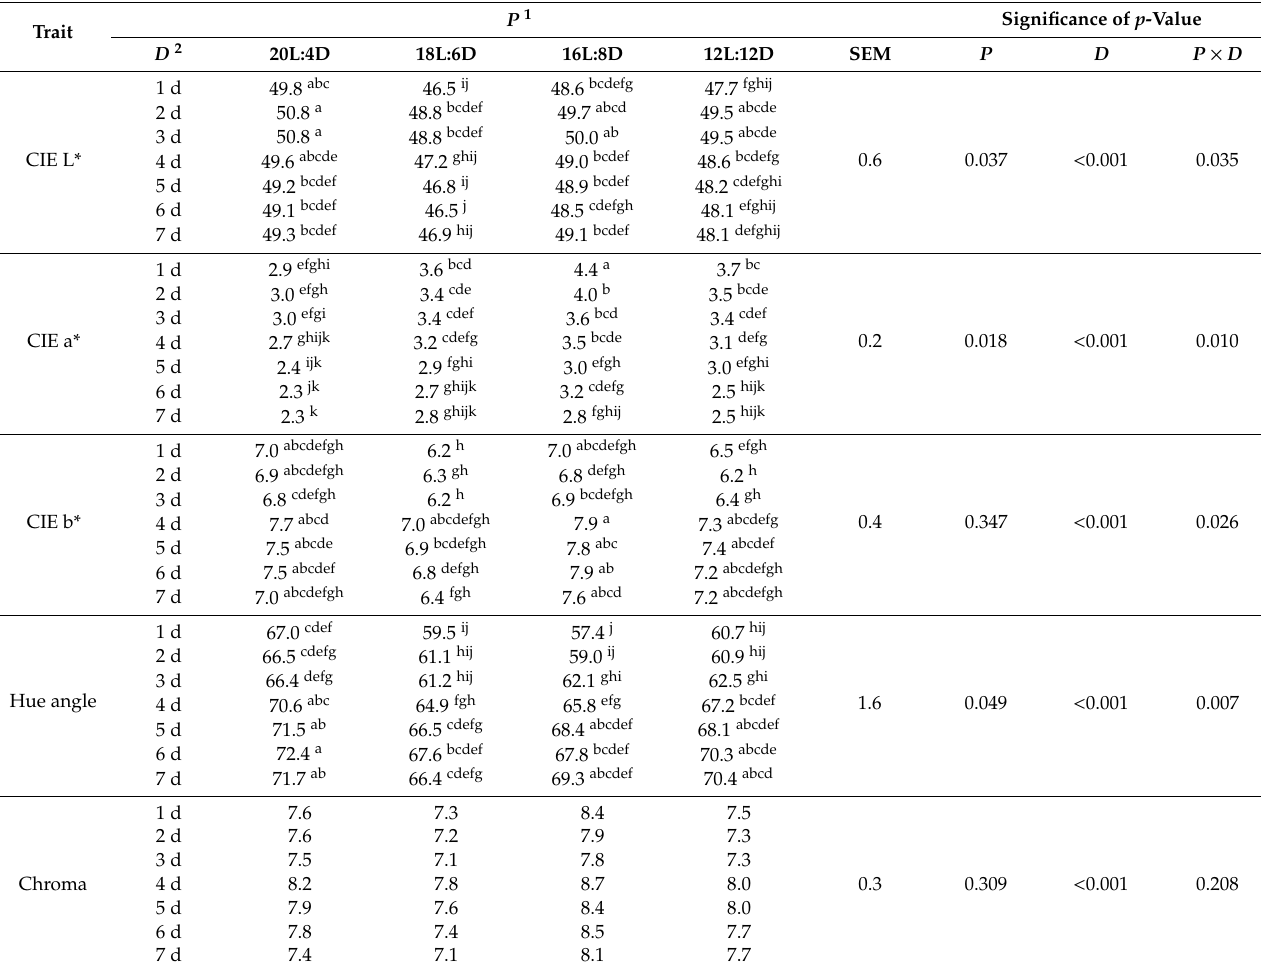
Table 4. E ff ect of photoperiod on D 65 instrumental color attributes [CIE L* (lightness), CIE a* (redness), CIE b* (yellowness), hue angle (discoloration), and chroma (color intensity)] of broiler fillet ( M. Pectoralis major ) muscles during 7 days of aerobic display ( n = 6 /